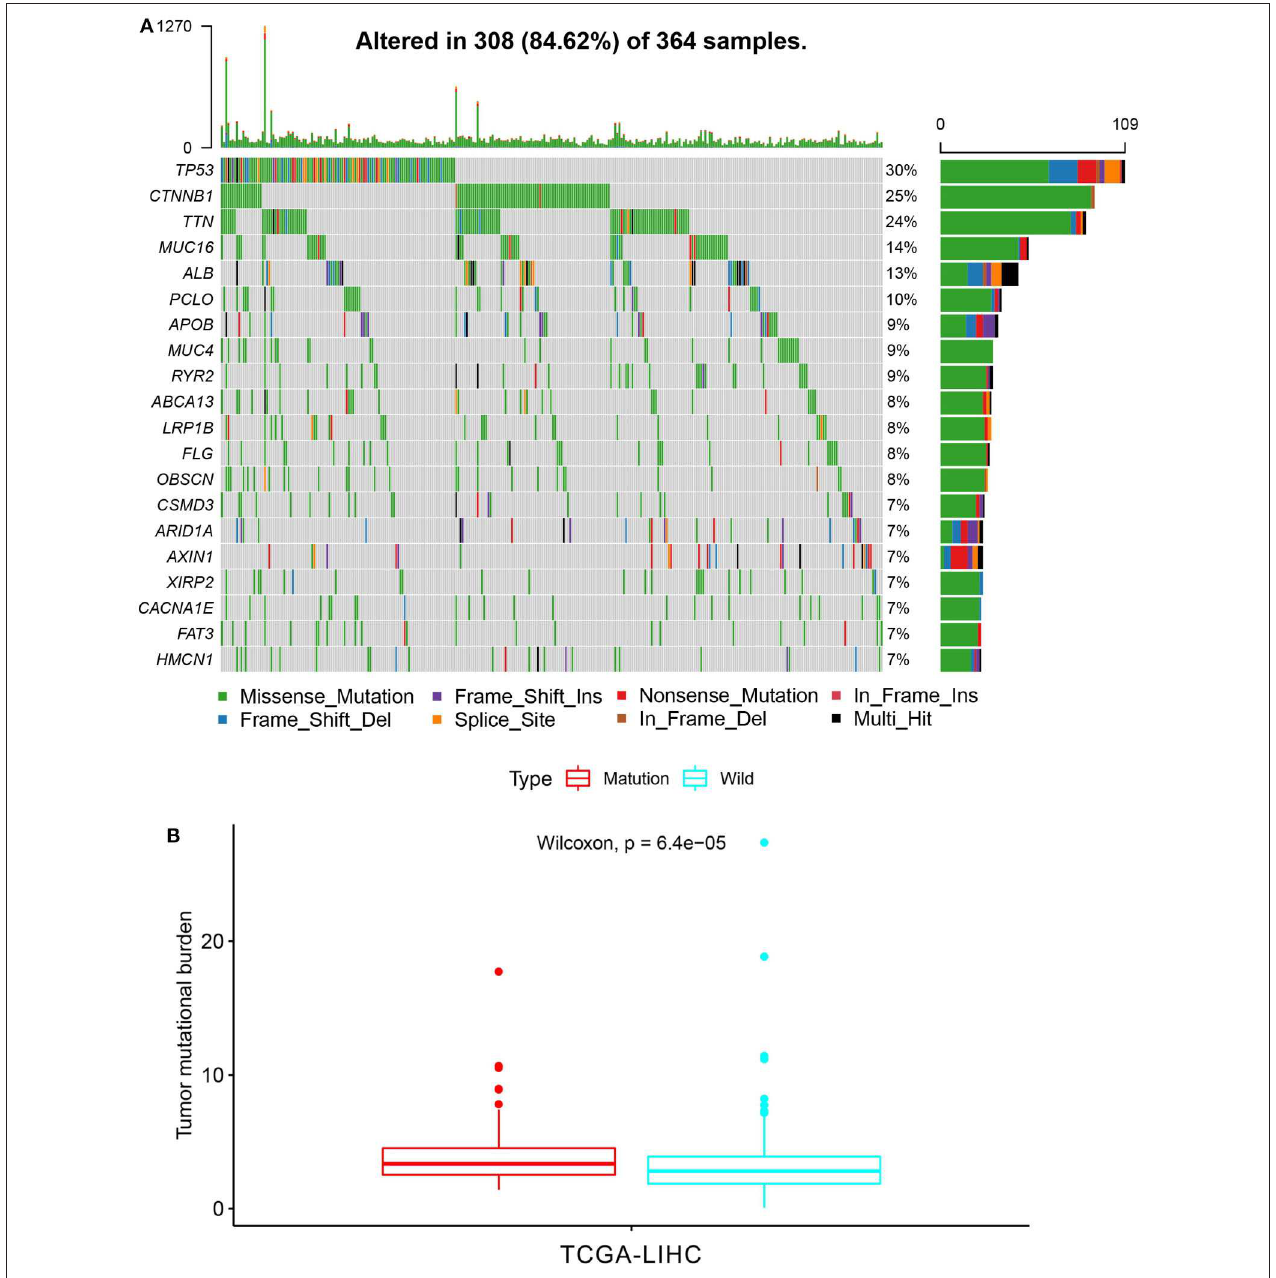
FIGURE 4 | Validation based on TCGA-LIHC cohort. (A) The waterfall plot of TCGA-LIHC. (B) Tumor mutational burden (TMB) correlation